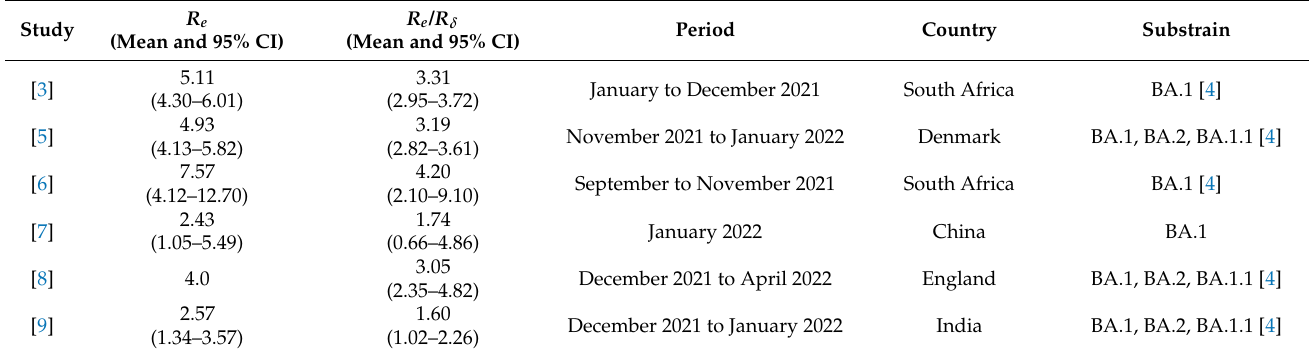
Figure 1. PRISMA (Preferred Reporting Items for Systematic Reviews and Meta-Analyses) flow diagram for the studies used to obtain studies that reported reproduction numbers. Table 1. Description of studies included for the Omicron variant of